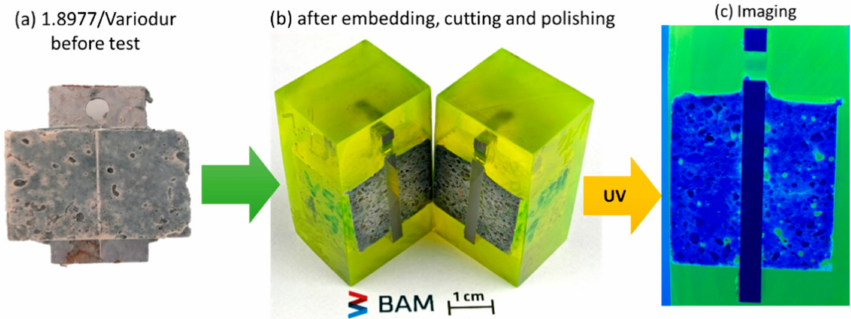
Figure 7. Control steel/Variodur specimen (without exposing to aquifer fluid and CO 2 ) before ( a ), after embedding, cutting, and polishing under white light ( b ) and blue light ( c ).